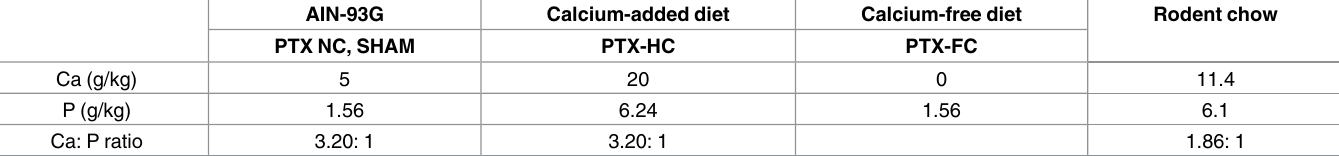
Table 1. Calcium and phosphorus components of the diets. Abbreviations: Ca, calcium; P,